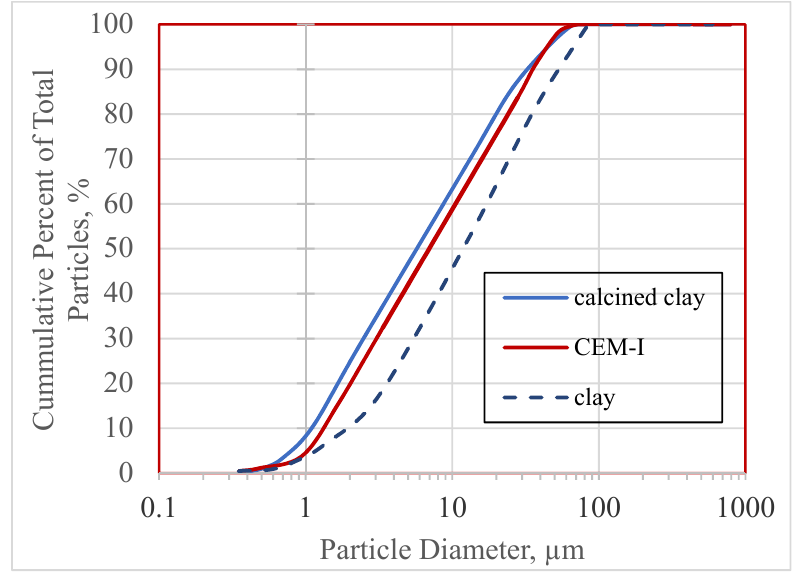
Figure 1. PSD of raw clay, calcined clay and CEM-I.